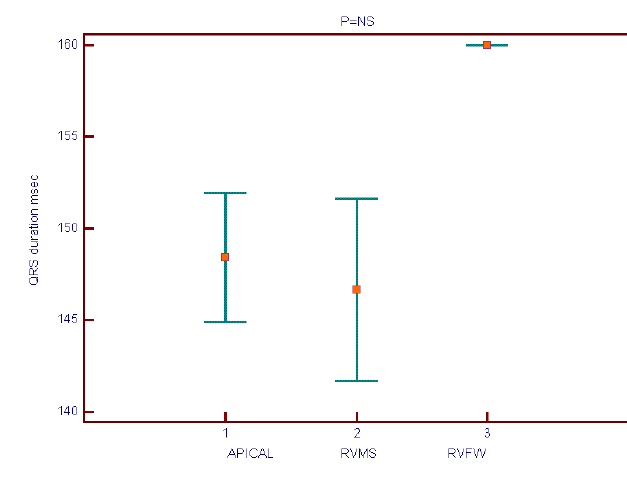
Fig. 2 - Largest QRS on 12 lead ECG (ms).